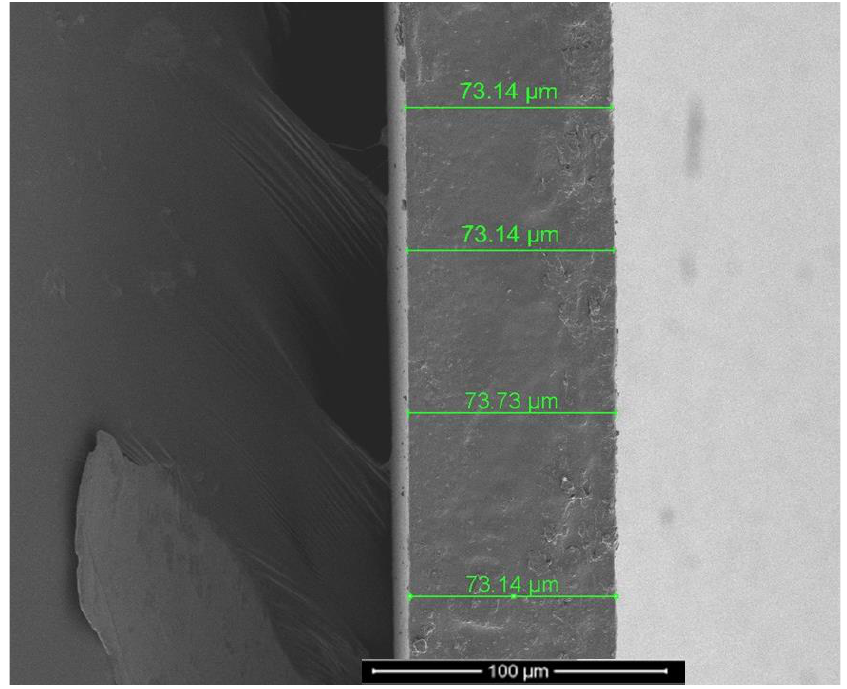
Figure 8. Cross-sectional image of NCMs (ZIF-8).